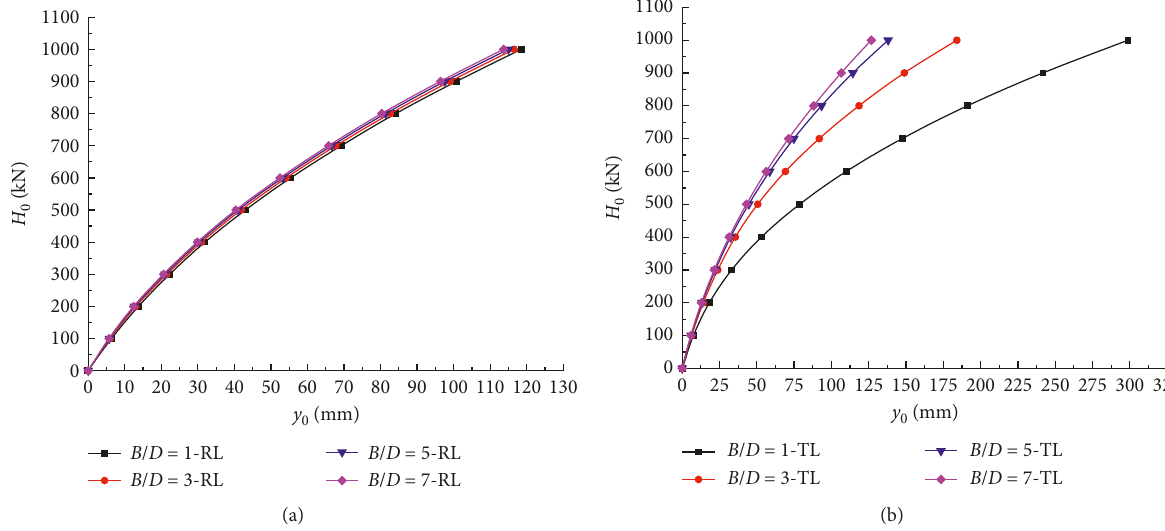
Figure 16: Pile head load-displacement curves under different loading directions for the 1V:1H slope. (a) Reverse loading. (b) Toward